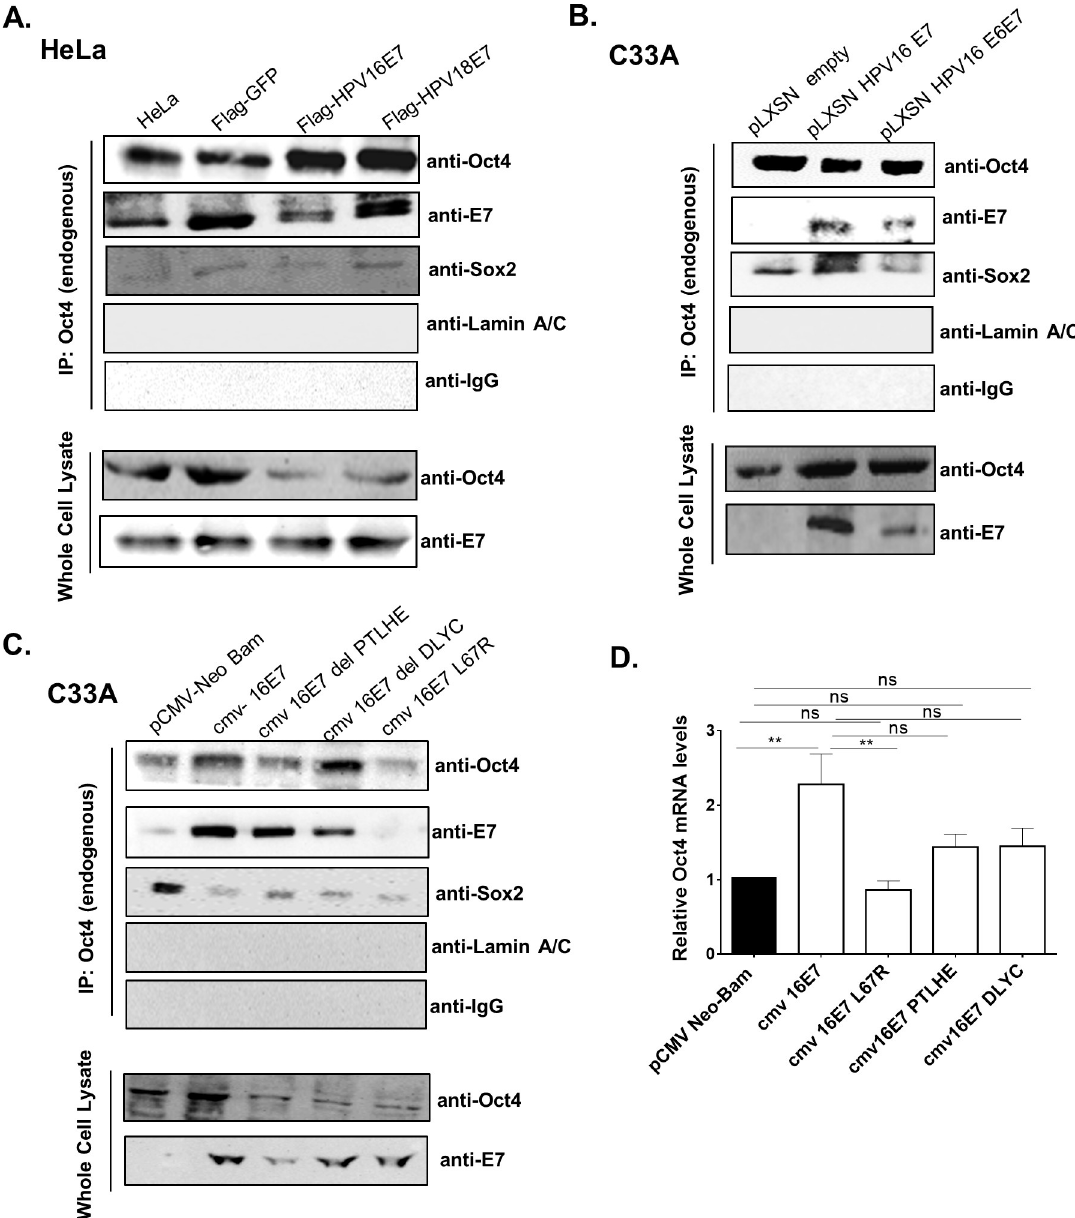
Fig 8. Oct4 interacts with HPV E7. (A) Co-immunoprecipitation analysis was performed in HeLa cells transduced with FLAG-tagged GFP, HPV16-E7 and HPV18-E7 vectors. Endogenous Oct4 was immunoprecipitated with IgG sepharose-beads and Oct4 interactors were revealed with Western blot. Antibodies for Sox2 and LaminA/C were used as a positive and negative control for Oct4 interaction respectively. IgG-antibody was used as a negative control for the immunoprecipitation experiment. (B) C33A cells transduced with either pLXSN-E7, pLXSN-E6E7 and pLXSN-empty constructs were used. Endogenous Oct4 was immunoprecipitated and interactions were visualised via western blot. Endogenous Oct4 interacts with E7. (C) C33A cells transfected with Mutants from the CR1 (del PTLHE), CR2 (del DLYC) and CR3 (L67R) domains of the E7 protein were used to test interaction with endogenous Oct4 (D) C33A cells were either transfected with pCMV-neo bam empty, cmv 16E7 wildtype or cmv 16E7 mutants. Cells were collected 48-hours post transfection and RNA was extracted for the analysis of Oct4 mRNA levels with qRT-PCR. Three independent replicates (mean ± SEM) were used and statistical analysis was performed with Unpaired t-test (two-tailed) (ns = non-significant, � p < 0.05, �� p < 0.01, ��� p < 0.001, ���� p <